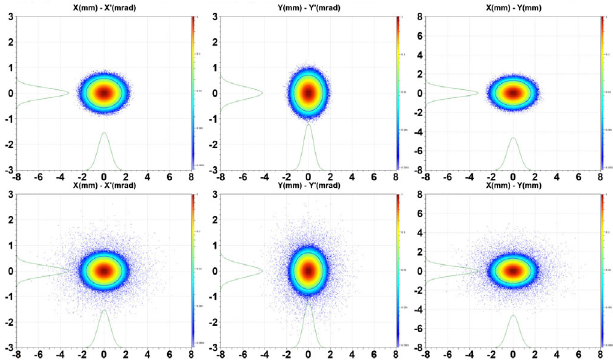
FIG. 11. Input distribution of collimation section. (Top for beam without halo, bottom for beam with 0.1% halo).